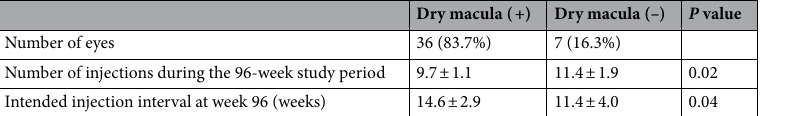
Table 1. Comparison between eyes with and without dry macula at week